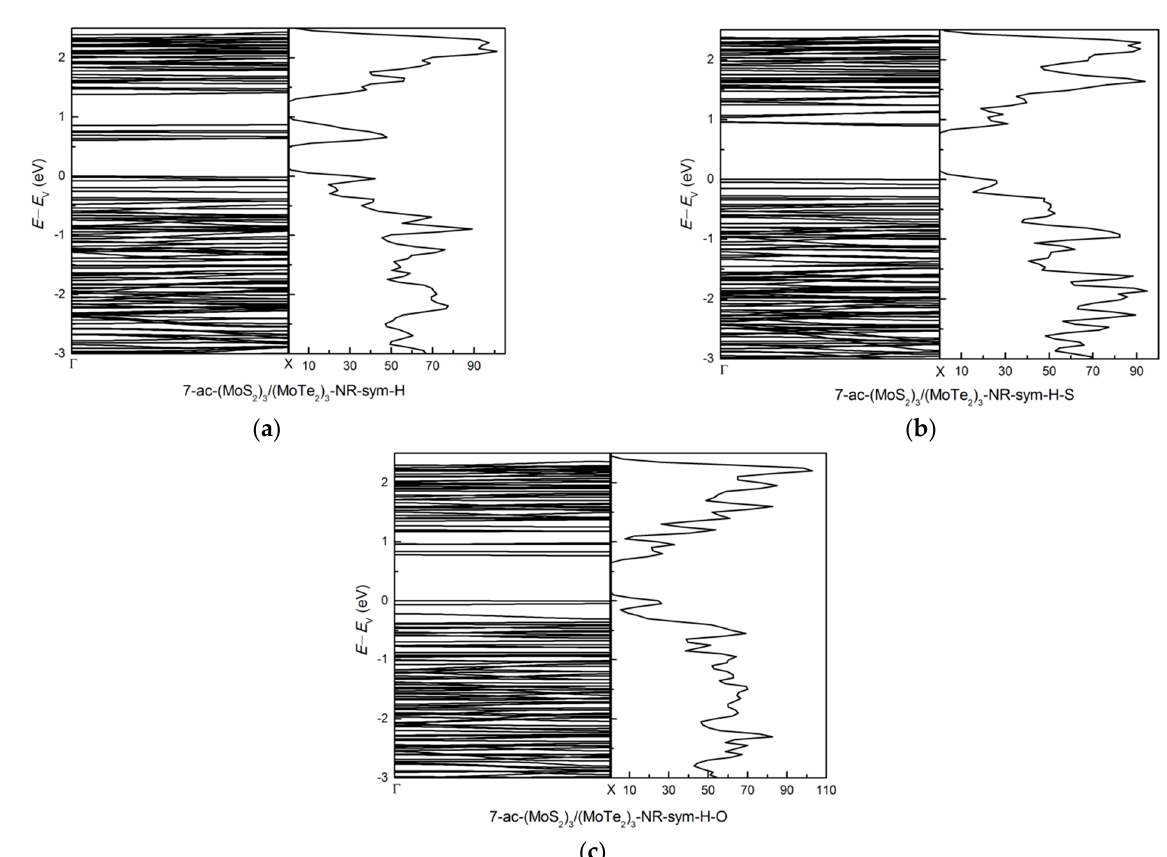
Figure 10. The band structure and dos: ( a ) 7-ac-(MoS 2 ) 3 /(MoTe 2 ) 3 -NR-sym-H, ( b ) 7-ac-(MoS 2 ) 3 /(MoTe 2 ) 3 -NR-sym-H-S